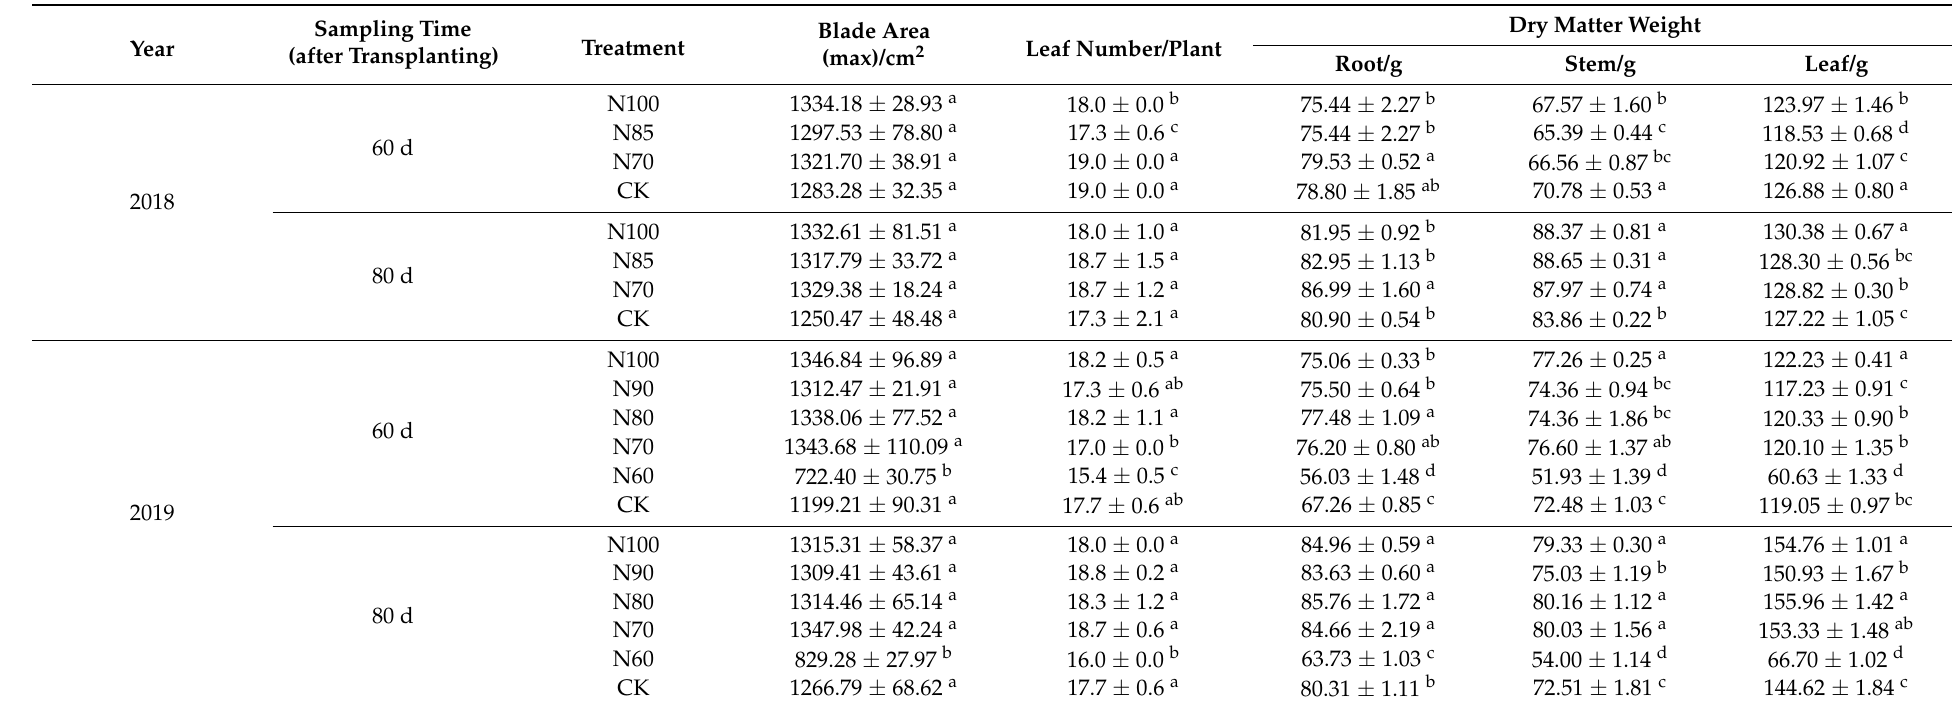
Table 4. Effects of reducing nitrogen application on agronomic